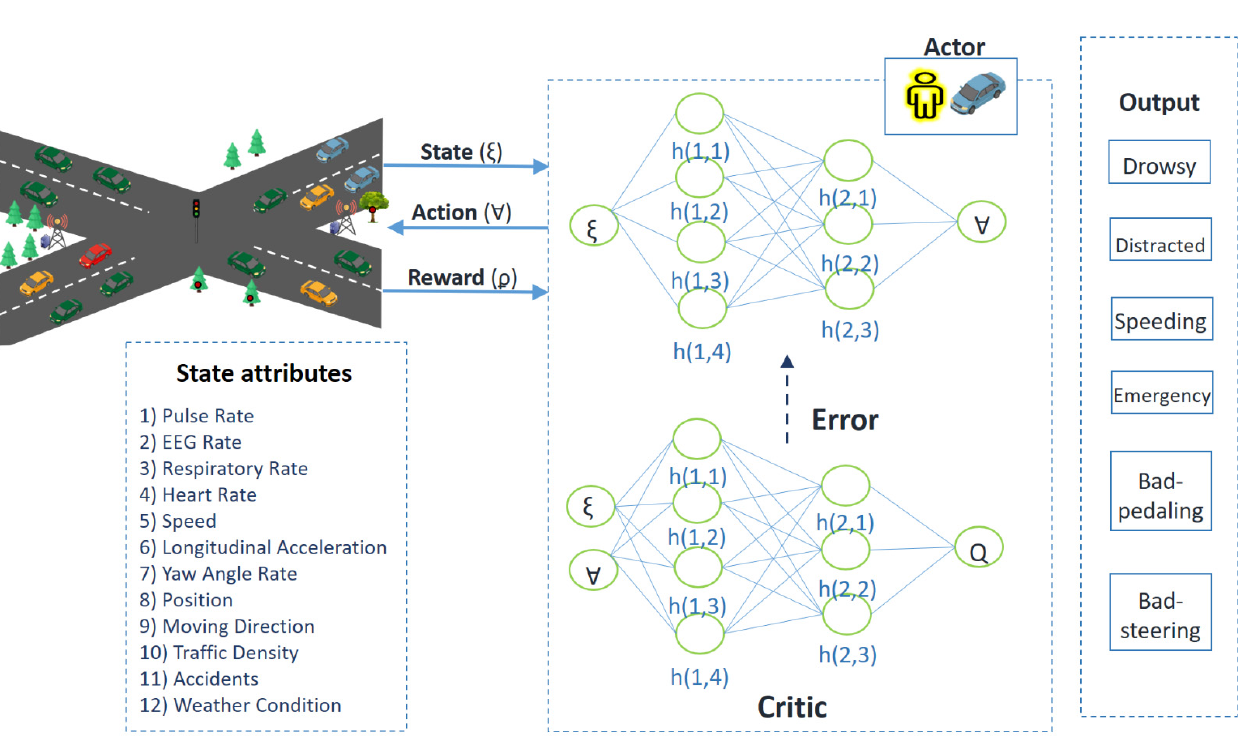
Figure 3. Driver Behavior Analysis Using A3C Algorithm.